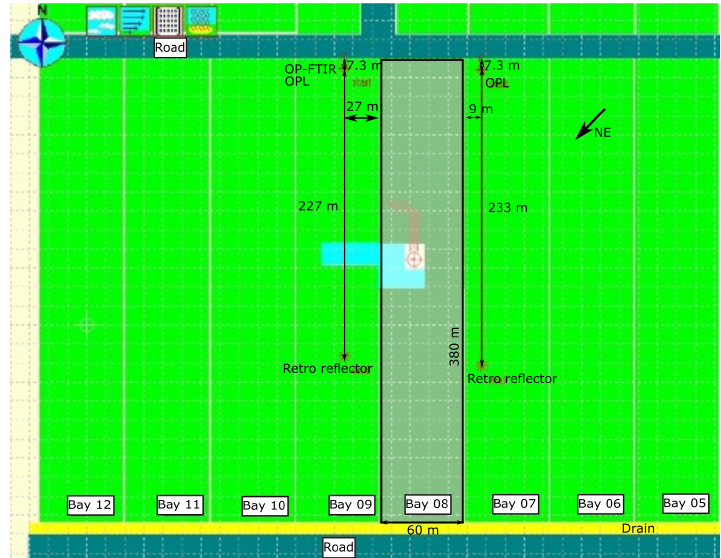
Figure A5. A WindTrax map showing the layout of herd emissions studied at Kyabram on 21 March 2006.